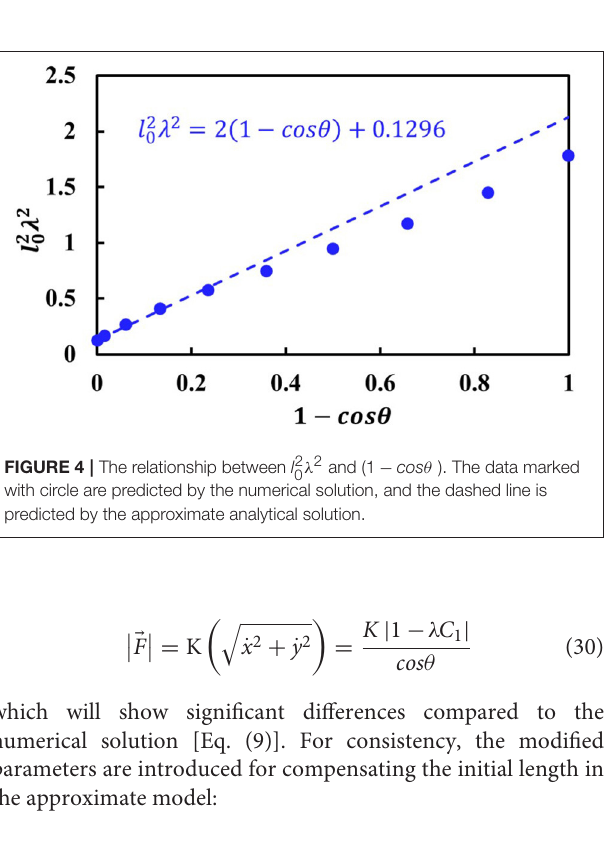
FIGURE 3 | Schematic of the instant that the first spring of the adhesive layer is detached from the substrate.